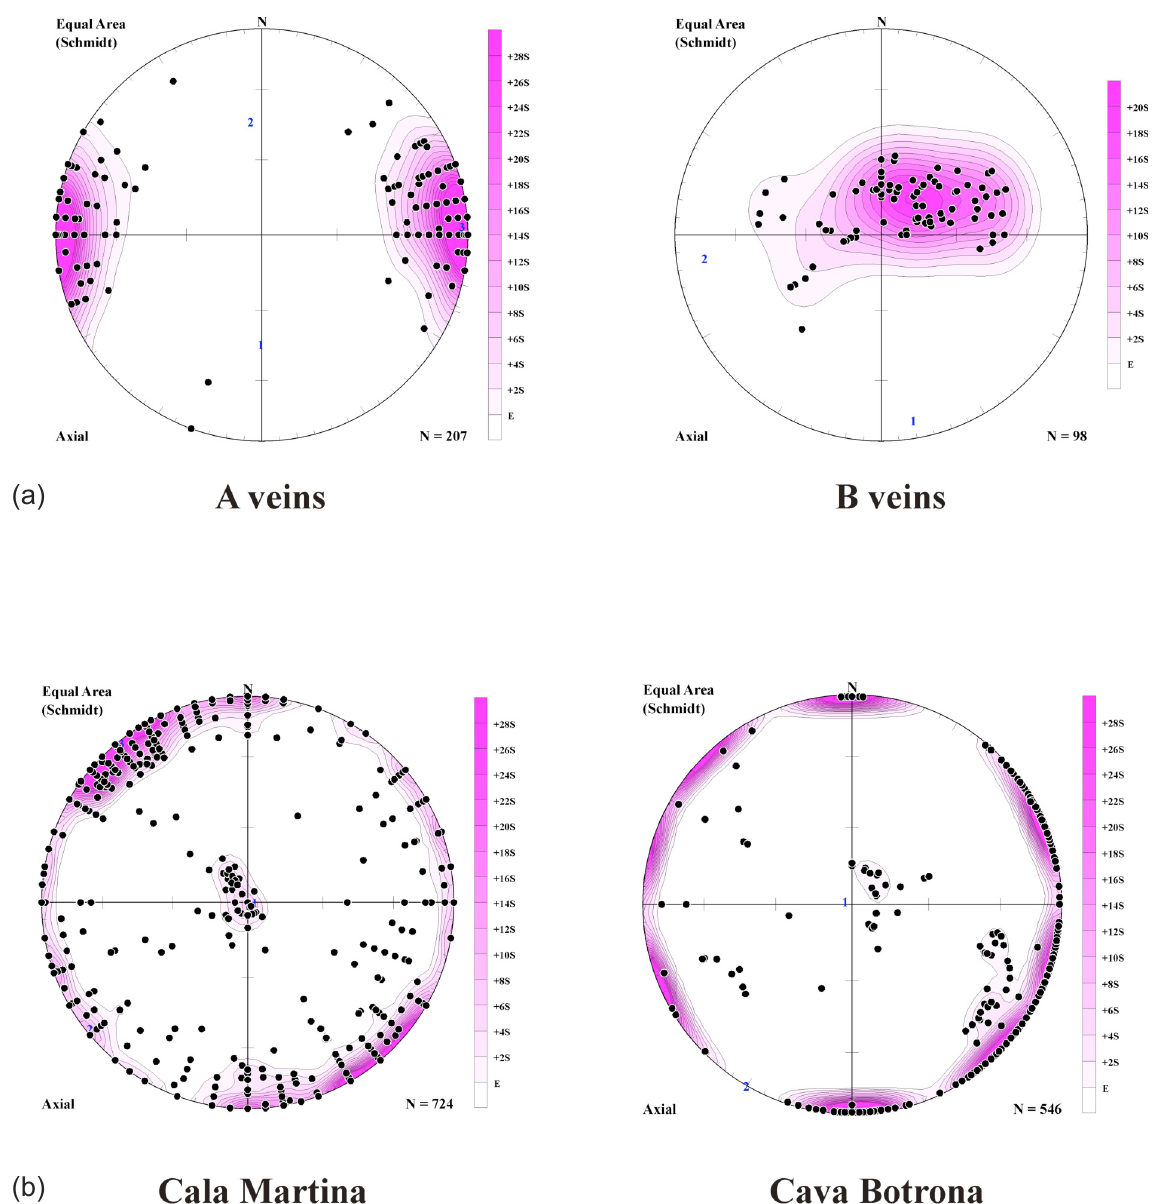
Figure 3. (a) Lower hemisphere stereo plots of pole to veins for the CHS hydrothermal systems. (b) Lower hemisphere stereo plots of pole to veins for the SHS hydrothermal systems. Contouring is done by the number of counts (E) expressed as multiplies of standard deviation